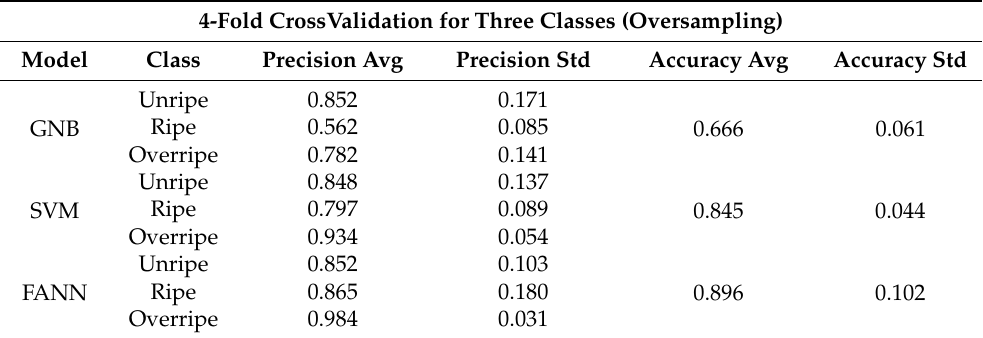
Table 10. Performance of three ML models for three-class classification using oversampling data. 4-Fold CrossValidation for Three Classes